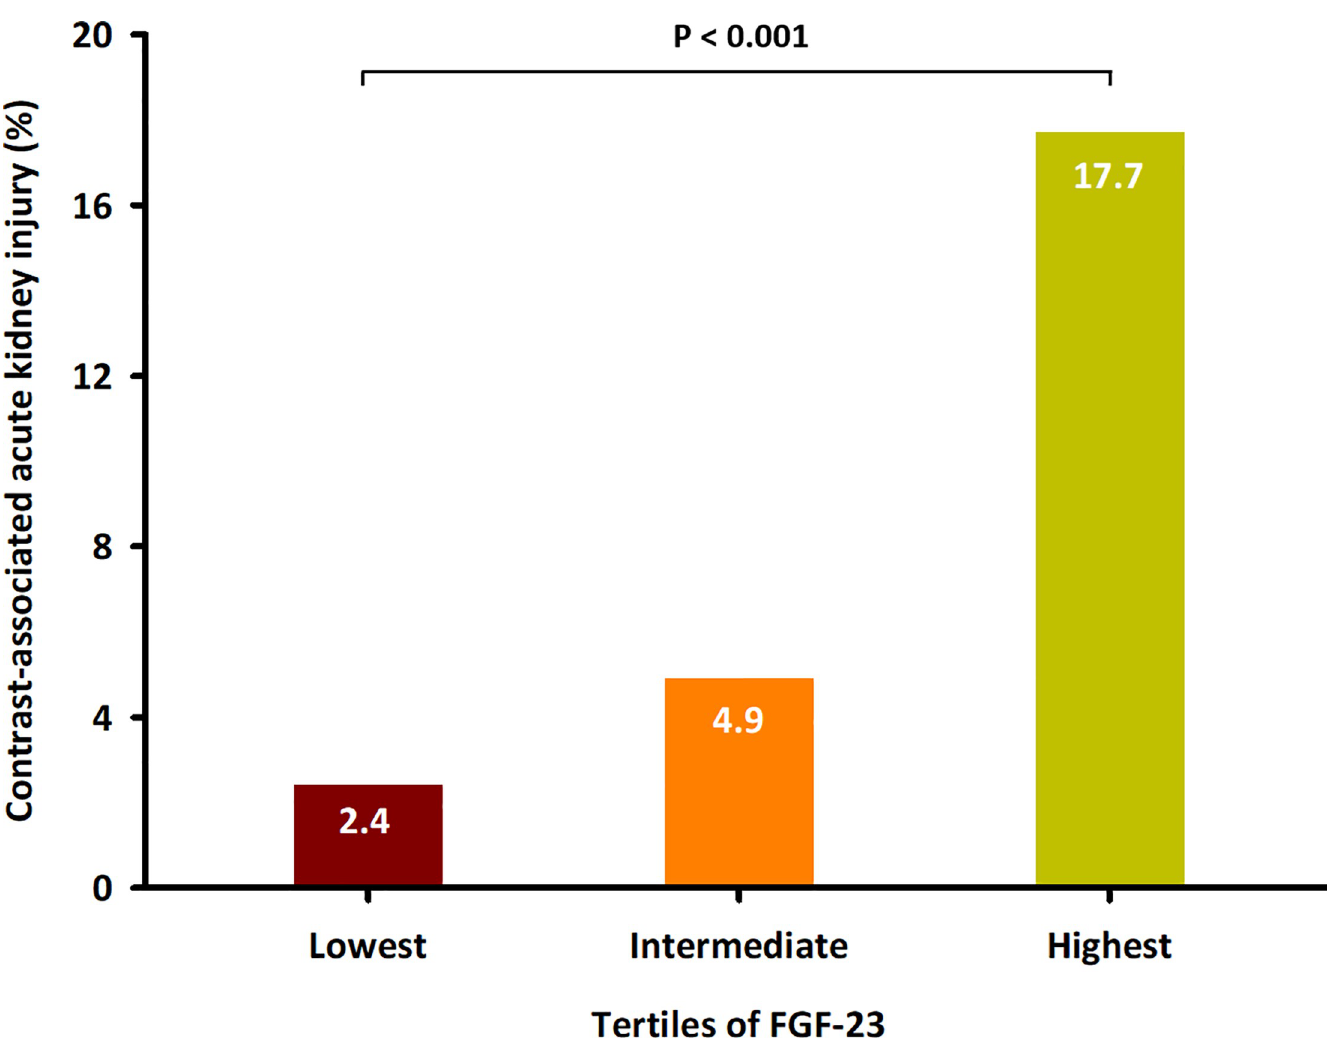
Fig 1. Incidence of contrast-associated acute kidney injury in patients stratified into 3 groups according to tertiles of FGF-23. P < 0.001.